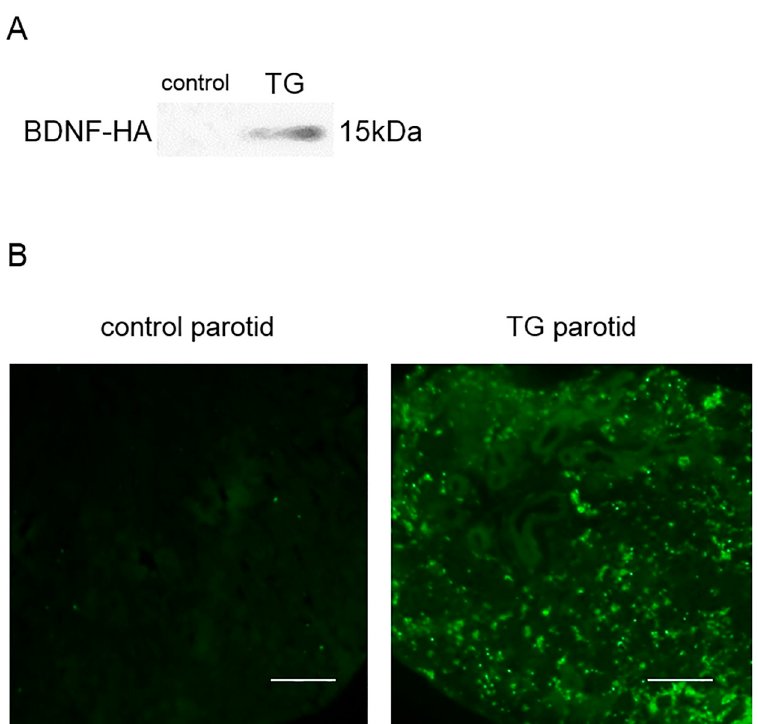
Figure 2. Expression of transgene product. ( A ) BDNF-HA was detected in the saliva of transgenic (TG), but not C57BL/6 control mice; ( B ) Hemagglutinin (HA) immunohistochemistry in the parotid gland. In C57BL/6 control mice, HA protein was not detected. In TG mice, HA protein was detected in acinar cells, but not detected in various duct-type cells or myoepithelial cells. Green color: immuno-positive HA staining. Bar = 100 μ m.